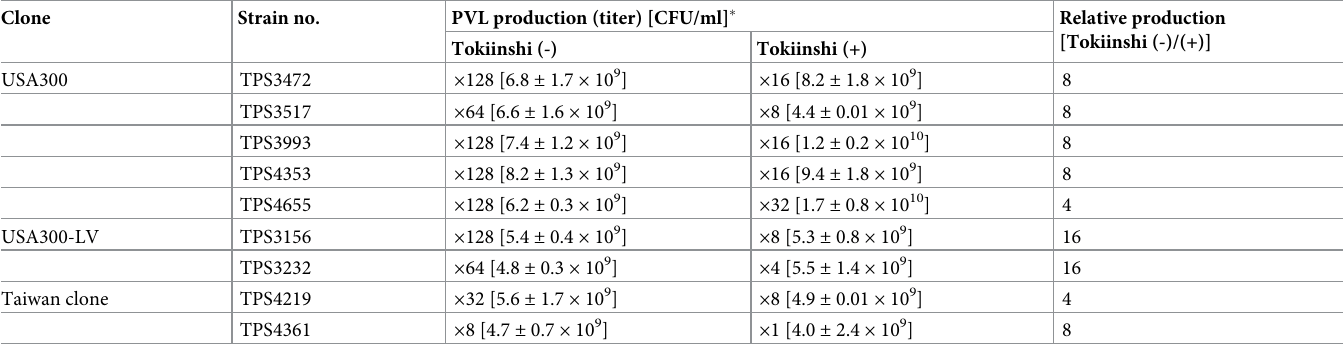
� CFU/ml data are shown as mean ± standard error of mean